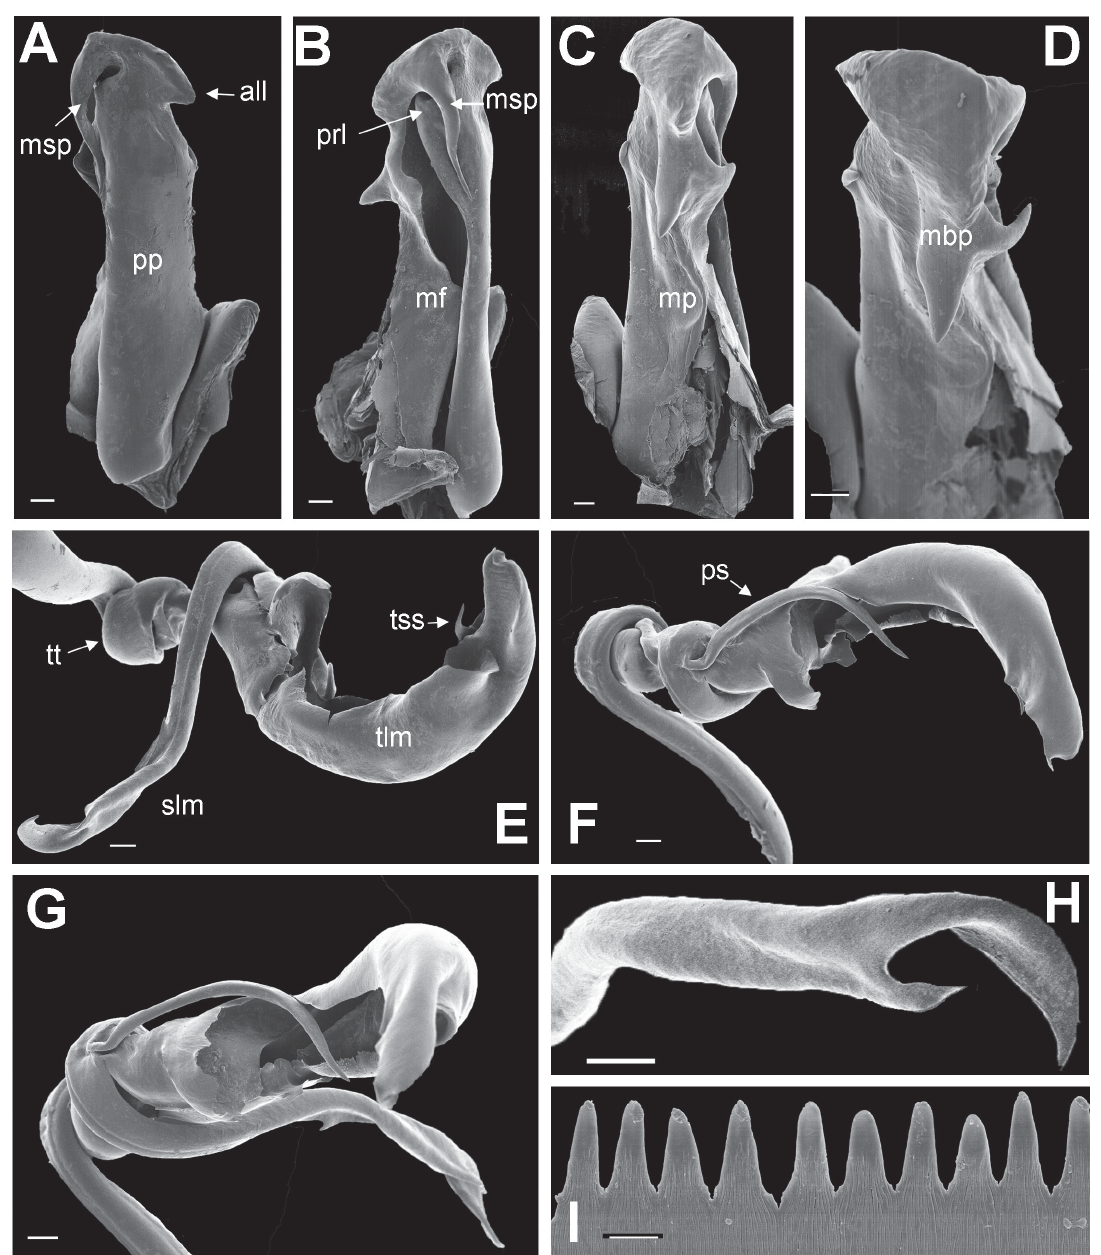
Fig. 7. Utiliverpa decapsulatrix gen. et sp. nov., holotype. A–D . Right gonopod coxa. A. Anterior view. B. Mesal view. C. Posterior view. D. Posterior-apical view. E–H . Left gonopod telopodite. E. Anterior view. F. Posterior view. G. Mesal-anterior-apical view . H. Solenomere. I . Limbus. Abbreviations: All = apical lateral lobe of coxa, mbp = metaplical bifid process, mf = metaplical flange, mp = metaplica, msp = metaplical spine, prl = proplical lobe, pp = proplica, ps proximal solenomeral spine, slm = solenomere, tlm = telomere, tss = telomeral subapical spike, tt = torsotope. Scales: A–H = 0.1 mm; I = 0.01